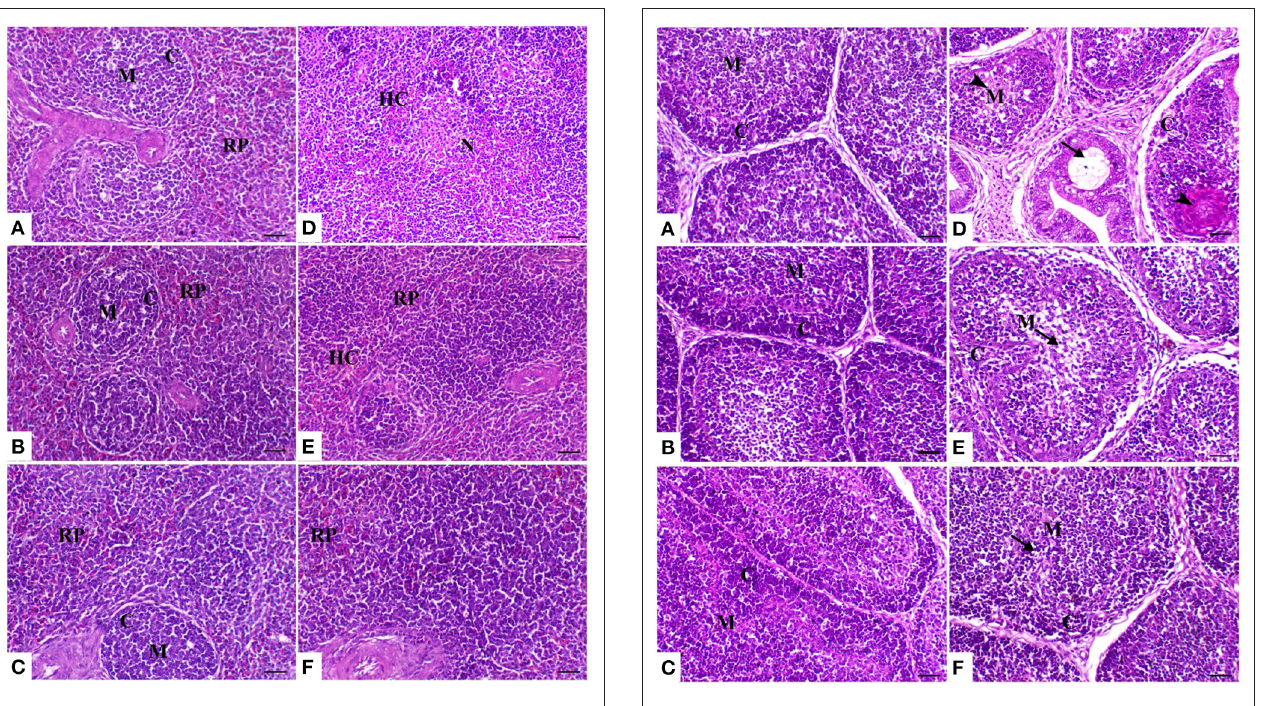
FIGURE 4 | Bursa of Fabricius sections of the different treated groups. (A) Spleen of the control group showing normal lymphoid follicles separated with slight fibrous connective tissue septa (M and C indicate the medulla and cortex of the lymphoid follicle, respectively). Sham groups (B) R and (C) E revealing normal lymphoid follicles. (D) Spleen of heat stress (HS) group showing marked atrophy of the lymphoid follicle with medullary necrosis (arrowheads), interstitial fibrosis, and mucosal cyst formation (arrow). (E) Spleen of HS + R showing medullary lymphoid depletion (arrow). (F) Spleen of HS + E showing a marked restoration of lymphoid content within the follicle. H&E, × 200, bar = 50 µ